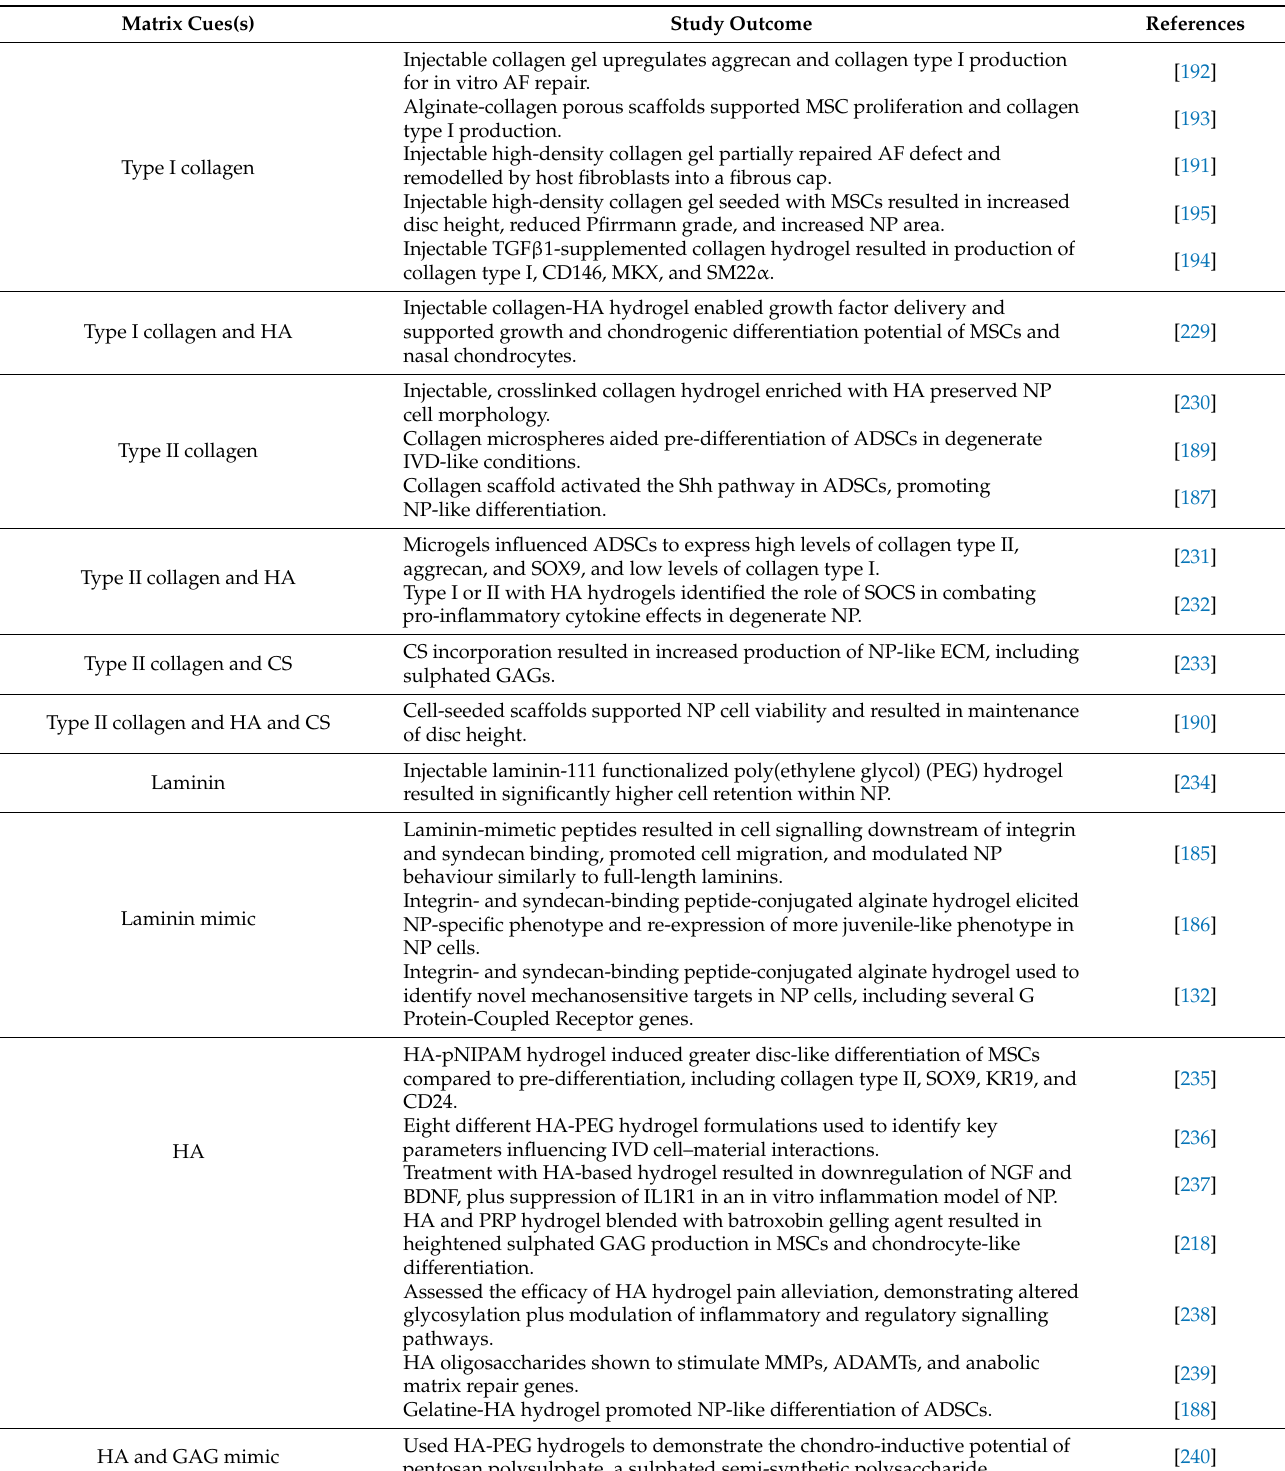
Table 3. Matrix molecules incorporated into biomimetic systems for